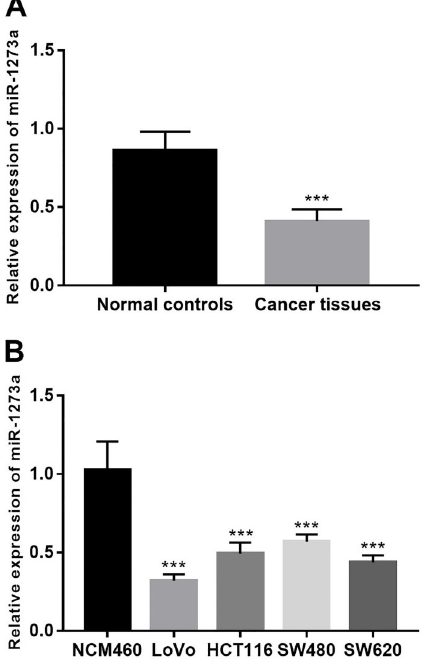
Figure 1. Expression of miR-1273a in colon cancer tissues and cell lines. A , The expression level of miR-1273a was down- regulated in colon cancer tissues compared with the adjacent normal controls. B , The expression level of miR-1273a in colon cancer cell lines was lower than in the normal controls. Data are reported as means ± SD. ***P o 0.001 (Student ’ s t -test or ANOVA followed by Tukey ’ s test). NCM460: normal colonic mucosa cell